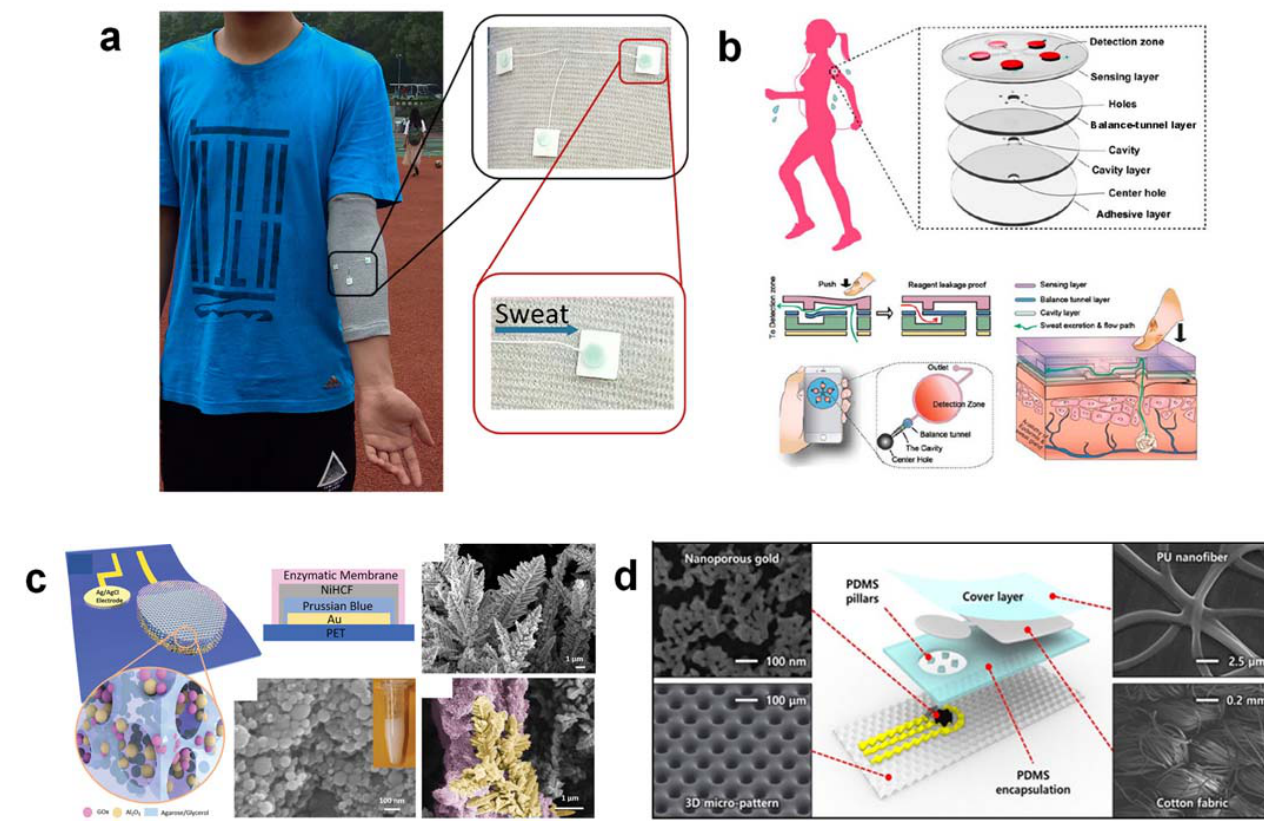
Figure 5. ( a ) A wearable microfluidic cotton thread/paper-based device linked to a smartphone for sweat glucose sensing. ( b ) A wearable colorimetric sensor based on microfluidic chips that detect sweat glucose easily and quickly. ( c ) Porous enzymatic membrane for highly stable nanotextured glucose sweat sensors to ensure reliable, non-invasive health monitoring. ( d ) A nanoporous electrochemical gold capillary microfluidic integrated sensor that is fully stretchable for continuous glucose monitoring. The figures are reprinted with permission from ref [8,49,50].